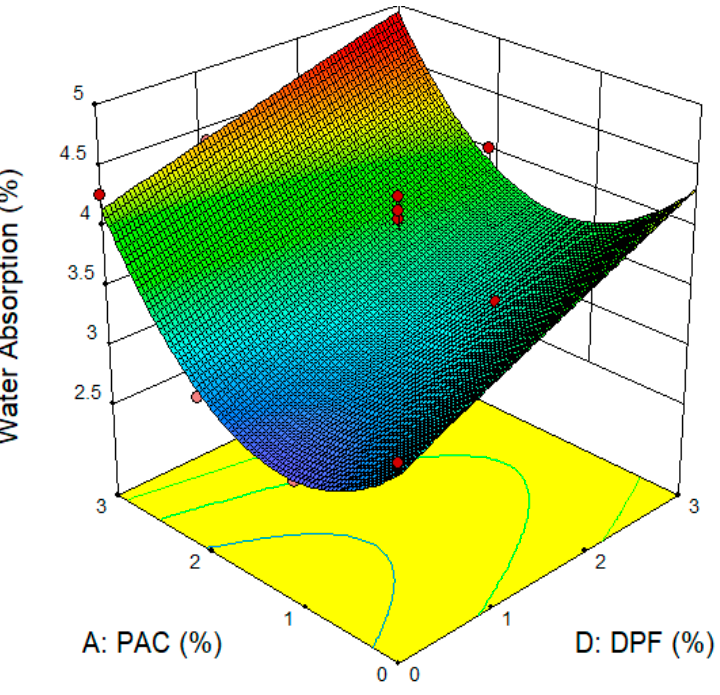
Figure 10. Surface Plots for Water Absorption.